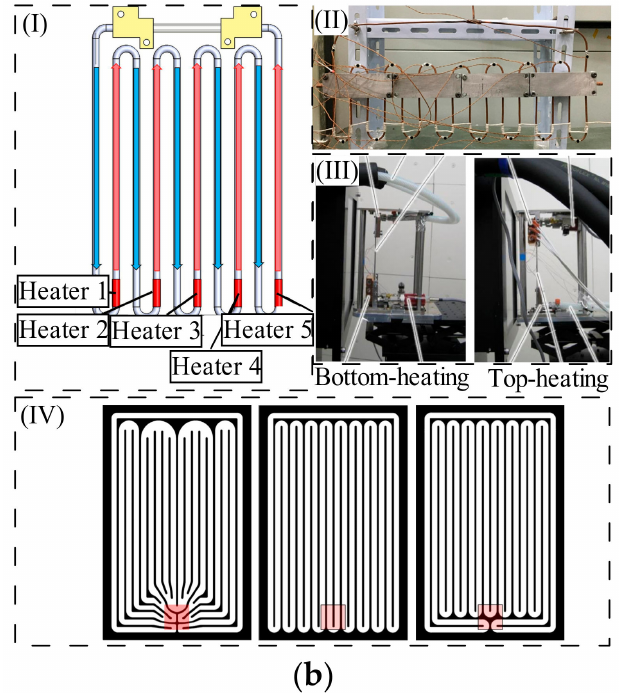
Figure 11. OHP for different heating methods. ( a ) OHP pulse heating and asymmetric heating method; ( b ) OHP for non-uniform heating and local heating. (I) [168]. Zhao et al., (2019); (II) [169]. Taft et al., (2017); (III) [171]. Chen et al., (2021); (IV) [170]. Chu et al., (2022); ( b ) OHP for non-uniform